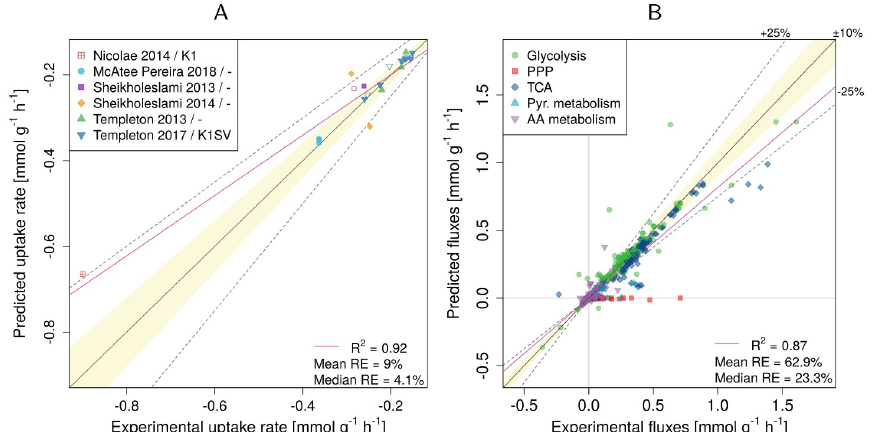
Fig 4. Experimental vs. predicted fluxes using minimization of glucose uptake rate as the objective function. (A) Experimental vs. predicted minimal glucose uptake rate. (B) Experimental vs. predicted intracellular fluxes. Results are shown for R_biomass_cho as the biomass reaction. RE—relative error. The legend in panel (A) indicates the publication and the used CHO cell line (if the information was available). Empty symbols indicate non-producers.